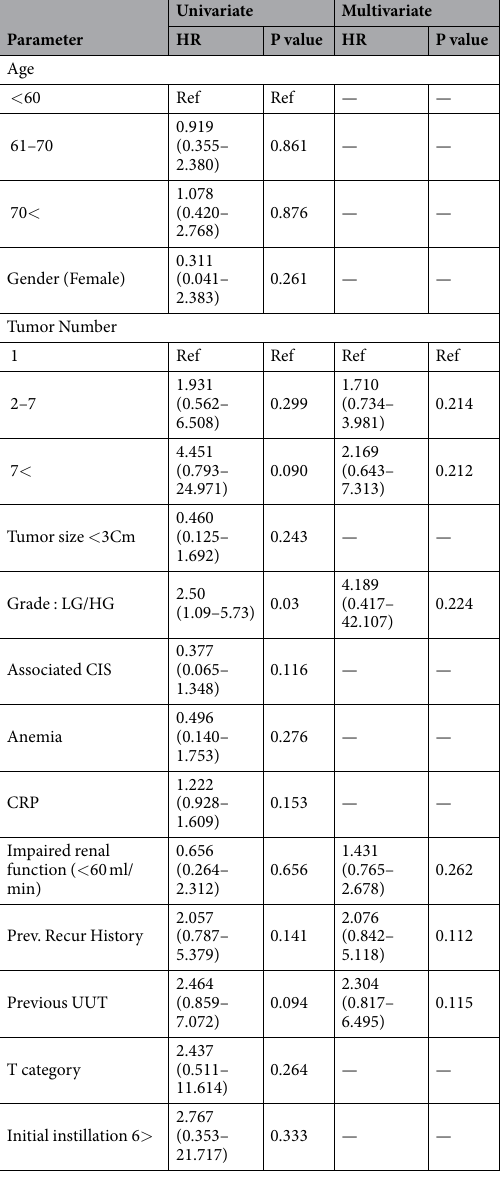
Table 4. Univariate and multivariate analyses of predictors for progression after intravesical BCG